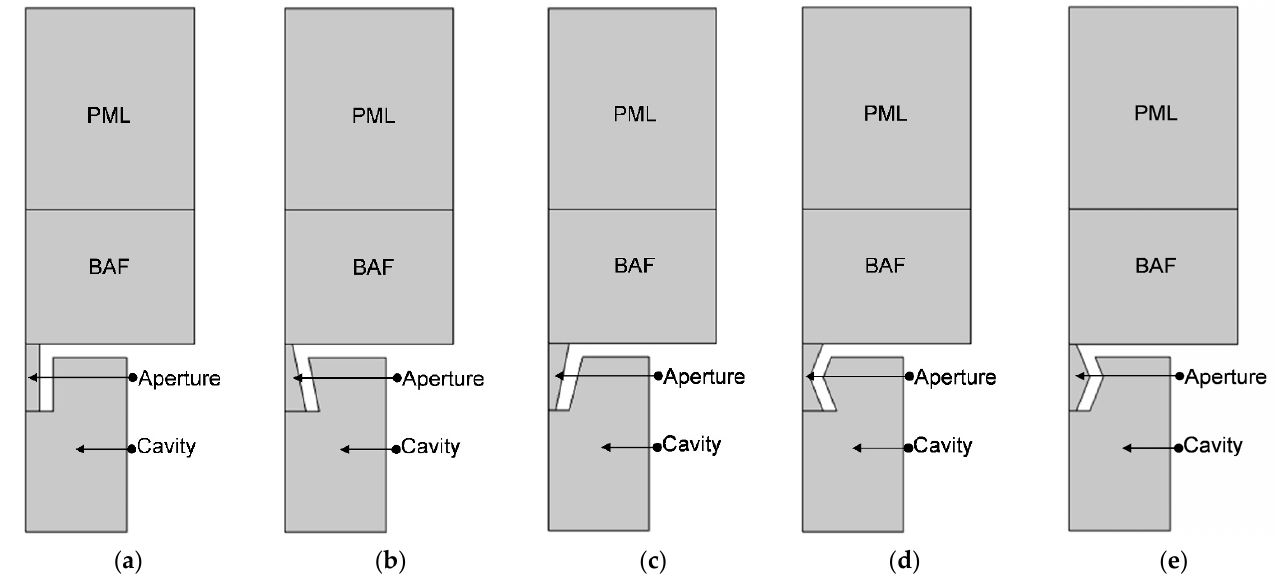
Figure 5. The two-dimensional rotational symmetric acoustic finite element model of HRs with the aperture for various tangent sectional shapes. ( a ) Rectangle; ( b ) common trapeziform; ( c ) reverse trapeziform; ( d ) dumbbell; and ( e ) olive.